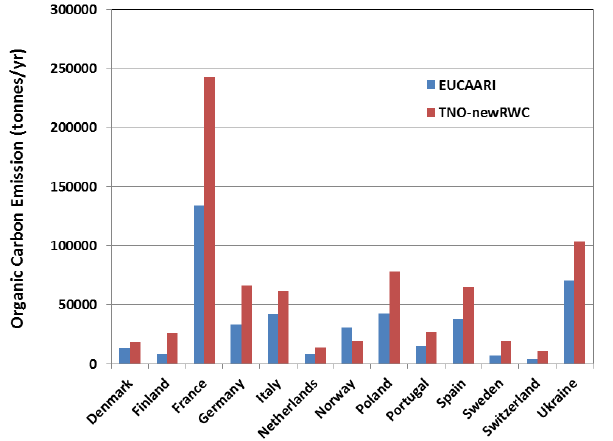
Figure 3. Total organic carbon emissions (tCyr − 1 ) for selected countries according to the EUCAARI and the TNO-newRWC emis- sion inventories.